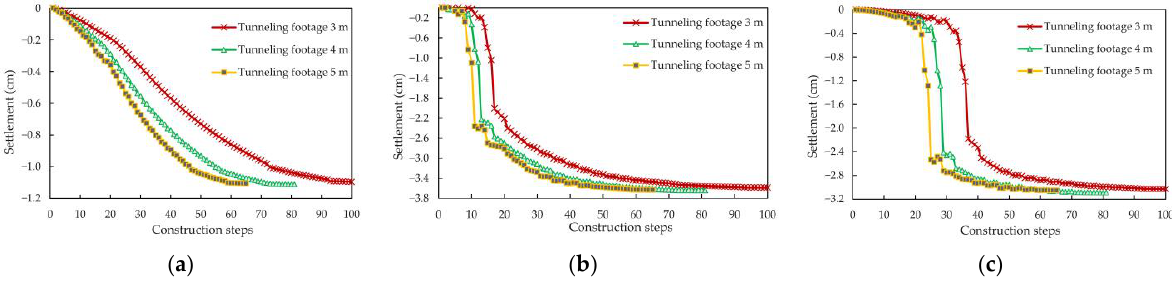
Figure 16. The vertical displacement curves of the surface, main line and ramp vault with different footage: ( a ) Surface; ( b ) Main line tunnel; ( c ) Ramp.